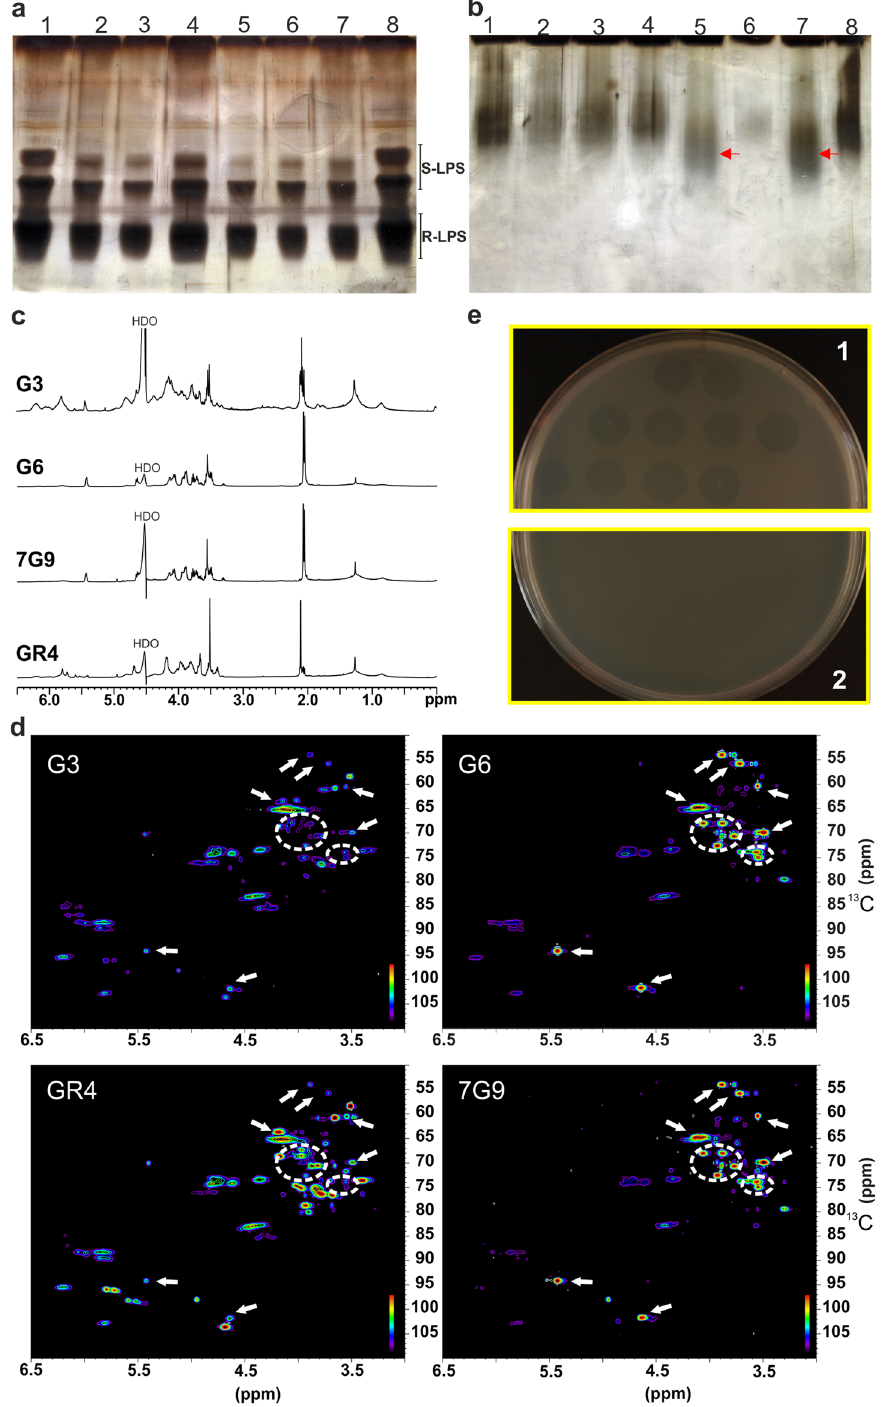
Figure 6. Analyses of the cell surface components of the isolates and resistance to phages. ( a ) SDS-PAGE of crude LPS extracts of various S. meliloti strains. The rough and smooth forms of LPS are indicated as R-LPS and S-LPS, respectively. ( b ) PAGE analysis of crude KPS extracts. For crude KPS extracts, samples were run in the absence of detergent (SDS), treated with Alcian Blue and silver-stained. Lane 1, GR4; lane 2, 2B40; lane 3, 2C67 (a field isolate with identical fingerprint to GR4 strain) 23 ; lane 4, G3; lane 5, G6; lane 6, 7E2; lane 7, 7G9; lane 8, GR4. The red arrows highlight the low-molecular mass capsular polysaccharide in the G6 and 7G9 isolates. ( c ) 1H-NMR spectra (500 MHz, 323 K), and ( d ) 1H-13C HSQC spectra of the high-molecular weight fraction isolated from G3, G6, 7G9, and GR4 cells. Signals from main component present in extracts from G6 and 7G9 are marked; these signals, at lower intensities, can also be found in G3 and GR4 extracts. ( e ) Phage infection test on GR4-type isolates. An example of phage plaques on GR4-type isolates from clade 1 (plate 1) and on resistant G6 or 7G9 cells (plate